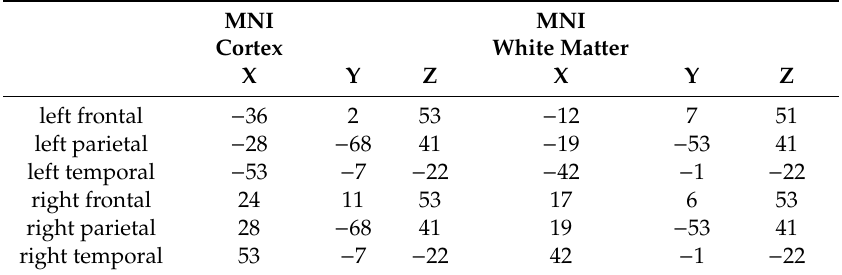
Table 2. Coordinates of the chosen frontal, parietal and temporal ROIs (regions of interest) in MNI (Montreal Neurological Institute) space. MNI MNI Cortex